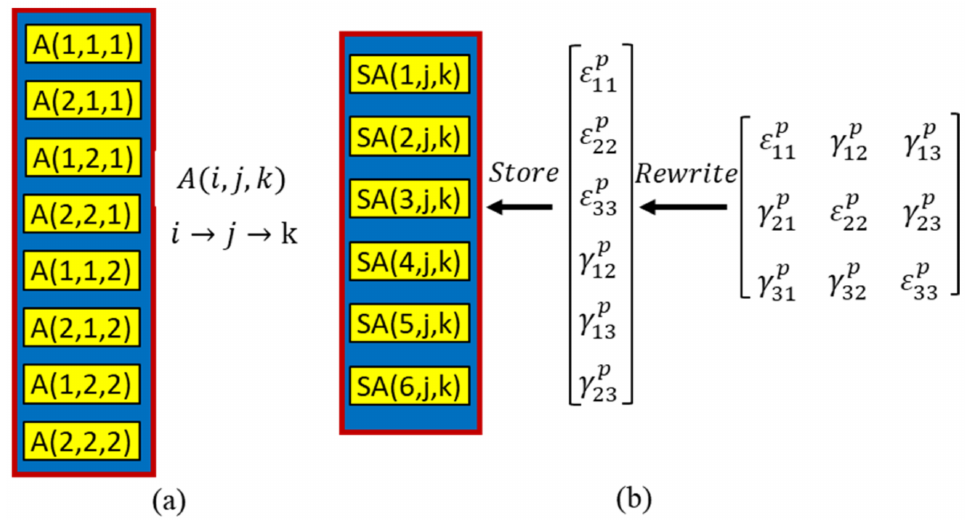
Figure 6. The storage format of arrays in Fortran ( a ), and the plastic strain tensor re-written into the vector to store in an array ( b